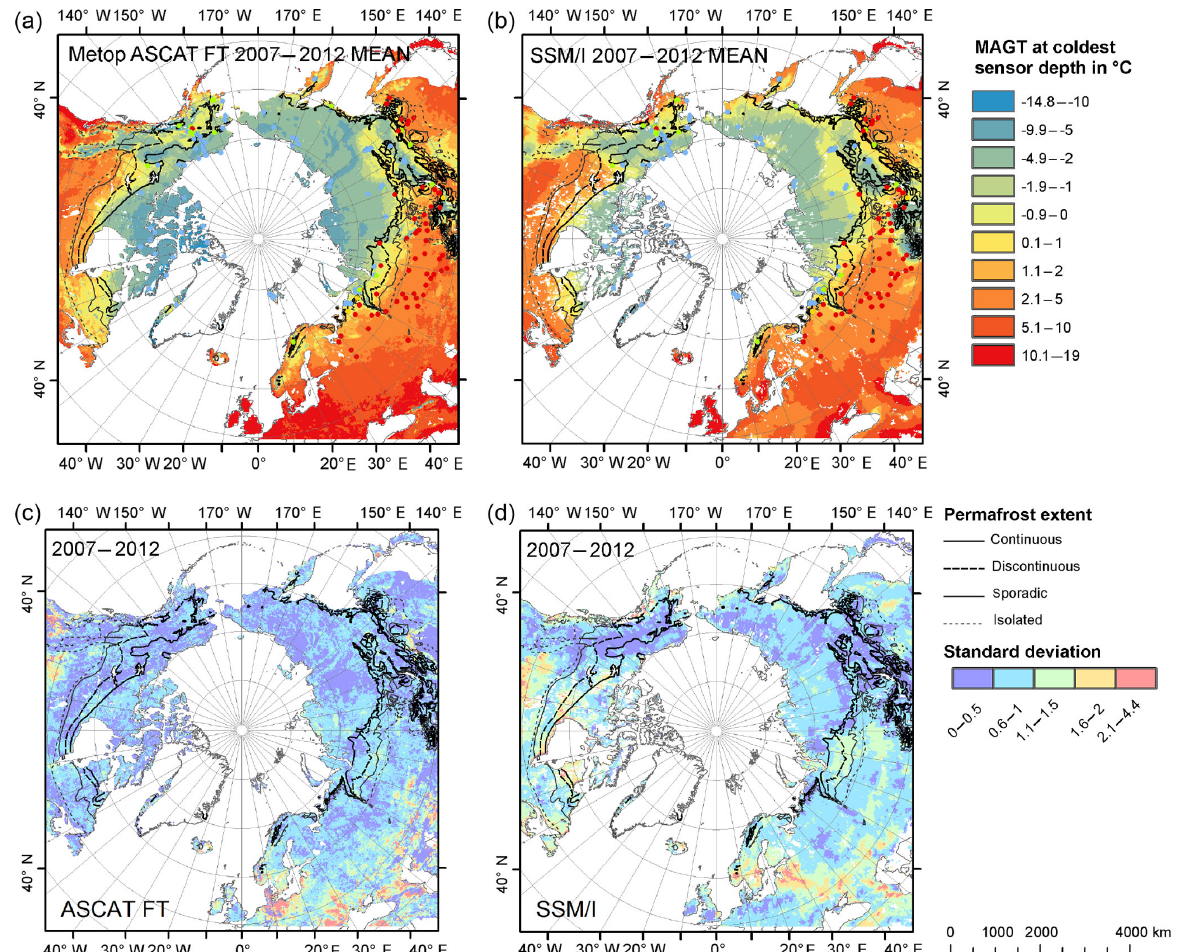
Figure 15. Maps of modelled mean annual ground temperature (a, b) and standard deviation of modelled MAGT c (c, d) for ASCAT excluding melt days (FT; a , c ) and SSM/I (b, d) based on all analysed years. Source for permafrost extent classes is Brown et al. (1997).